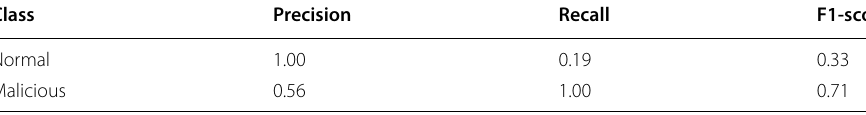
Table 21 Classification report of Naïve Bayes